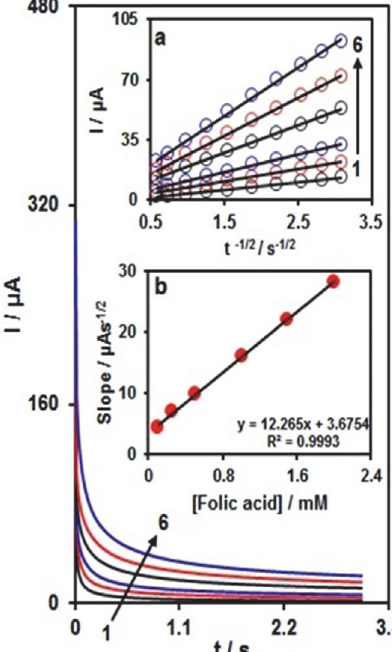
Fig. 6. Chronoamperograms obtained at NFO/SPE in 0.1 M PBS (pH 7.0) for different concentrations of folic acid. The numbers 1–6 corre- spond to 0.1, 0.25, 0.5, 1.0, 1.5 and 2.0 mM of folic acid. Insets: (a) Plots of I vs. t –1/2 obtained from chronoamperograms 1–6. (b) Plot of the slope of the straight lines against folic acid concentrations.